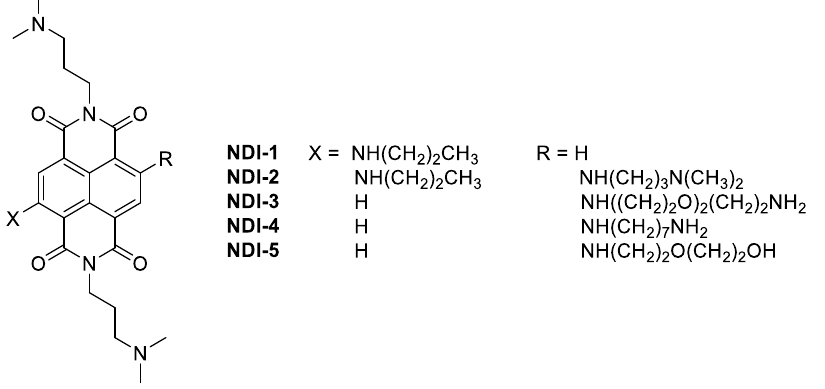
Figure 1. Chemical structures of the monomeric naphthalene diimides here investigated.